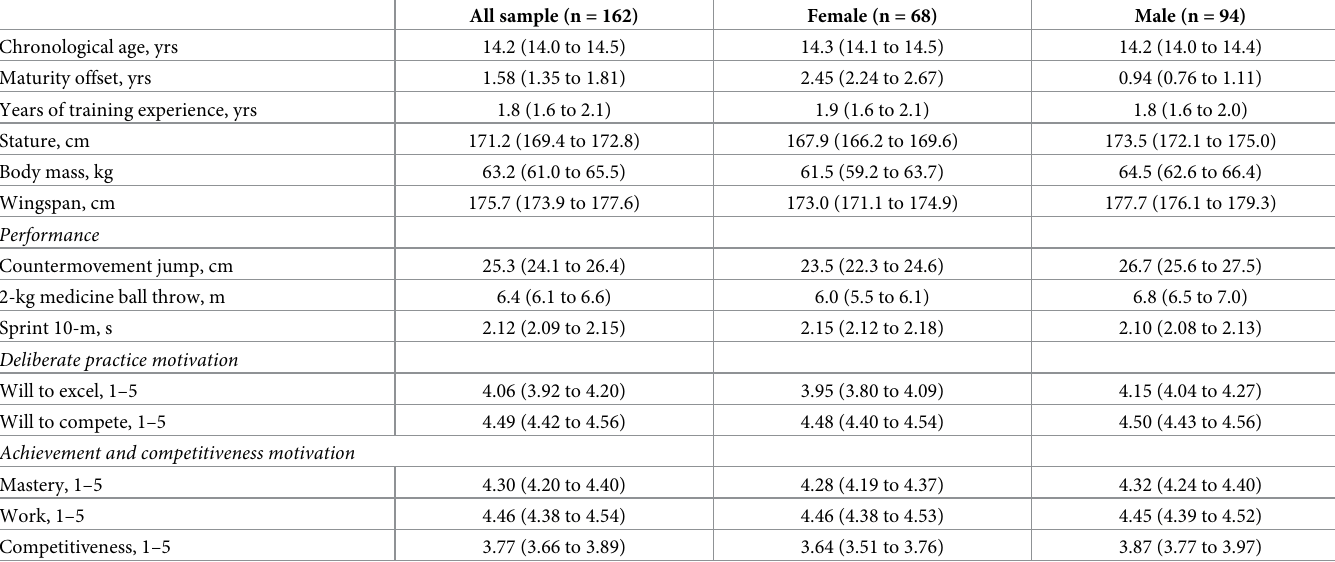
Table 1. Posterior estimations and 90% credible intervals of young Brazilian volleyball players by